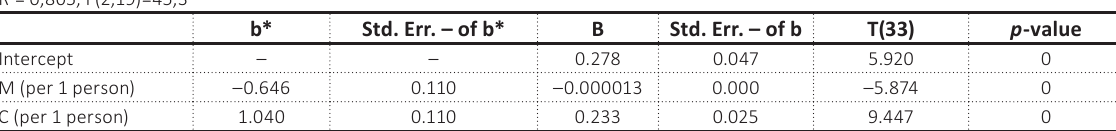
Table 2. The results of multiple linear regression analysis * The results of regression analysis for the dependent variable: A R 2 = 0,805,